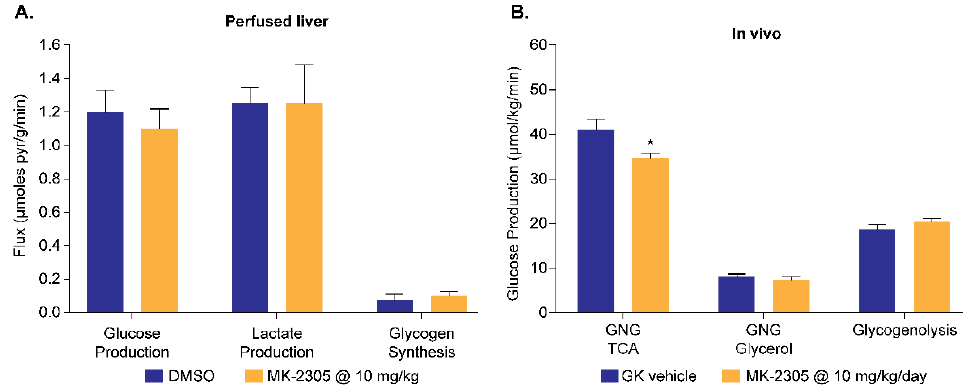
Figure 9. Using the perfused liver assay of GNG as part of an effort to elucidate the glucose lowering MOA of the GPR40 agonist MK-2305. ( A ) The lack of a direct effect of 10 μ M of MK-2305 on hepatic GNG in perfused db/db livers. ( B ) The in vivo effect of MK-2305 dosed at 10 mg/kg of PO to reduce GNG in GK rats in vivo using the 2 H 2 O approach. These results demonstrate that MK-2305 treatment indirectly reduces GNG. * P < 0.05 compared to GK vehicle. Adapted from reference [34].